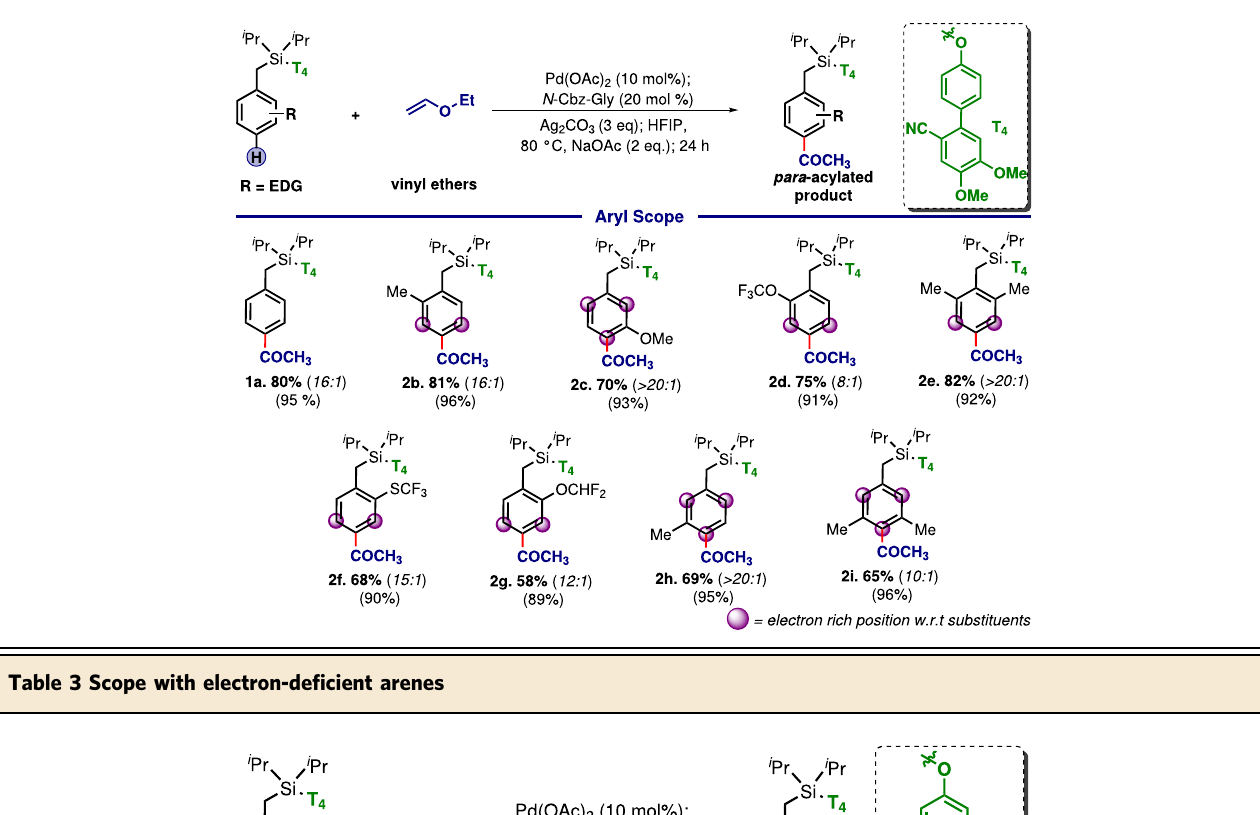
Table 2 The scope of electron-rich arenes